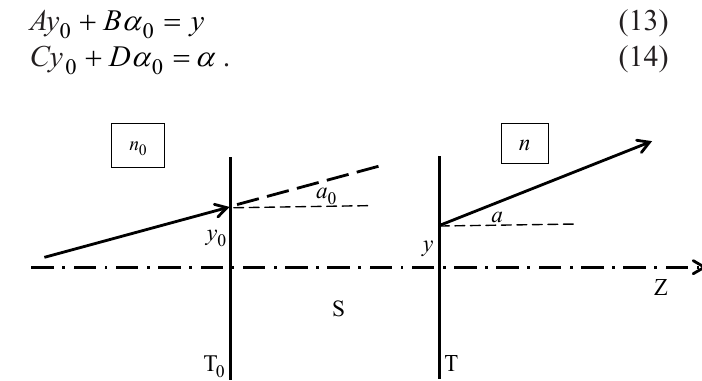
Figure 1 An arbitrary Gaussian optical system S lies between entrance plane 0 T and exit plane T. None of its refracting elements is shown. All elements are centred on the optical axis Z. A ray enters S with transverse position 0 y and inclination a and emerges with transverse position y and inclination a . 0 The ray is confined to the plane of the paper; Z lies in the same plane. The media before and after the system have indices of refraction 0 n and n